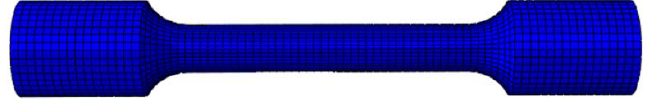
Figure 7. Numerical model of smooth bound bar specimen.